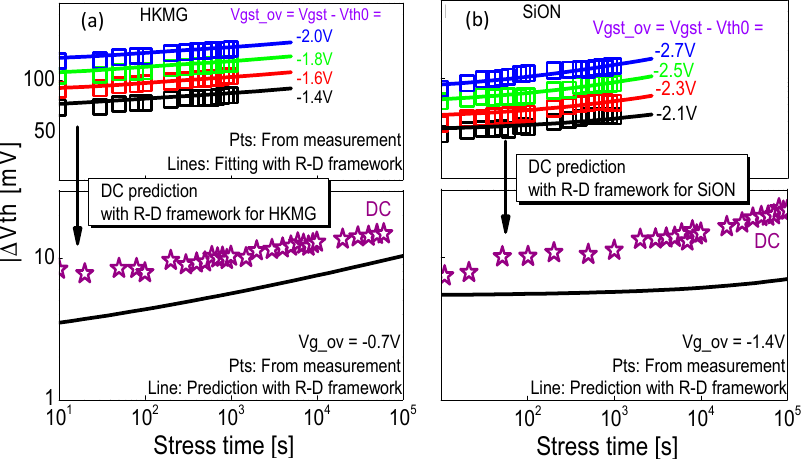
Figure 8. The reaction–diffusion (R–D) model could fit the test data well for both the high-k/SiON stack ( a ) and SiON ( b ). The model extracted from this fitting could not predict the NBTI at lower gate bias [36].